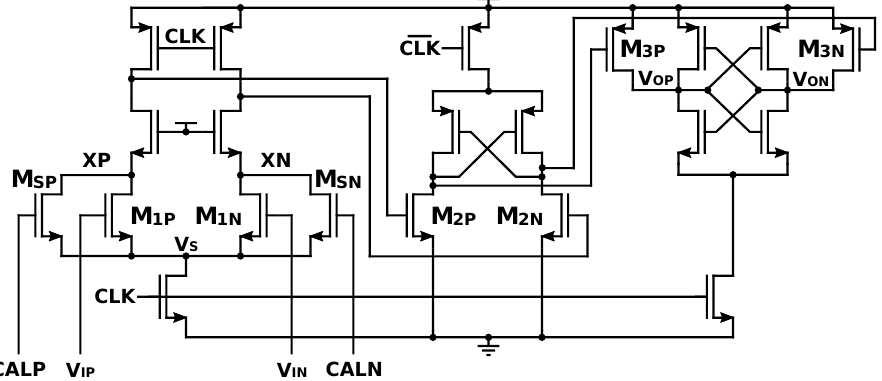
Figure 4. Comparator core with the extra offset compensating